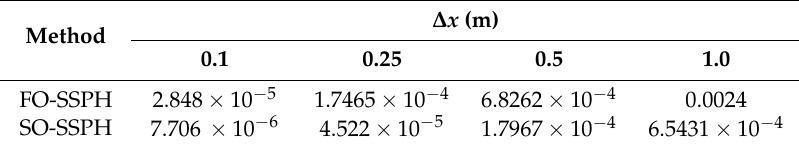
Table 2. Errors of FO-SSPH and SO-SSPH for one-dimensional heat conduction with Gaussian